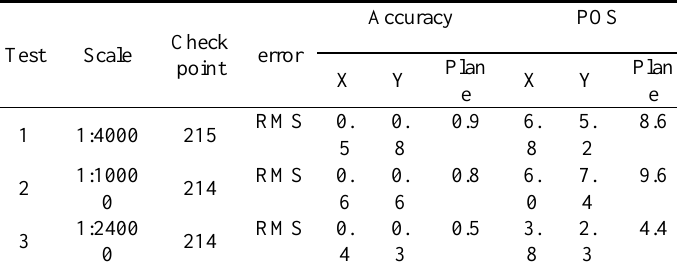
Table 1. Error of the orientation parameters （ in pixel